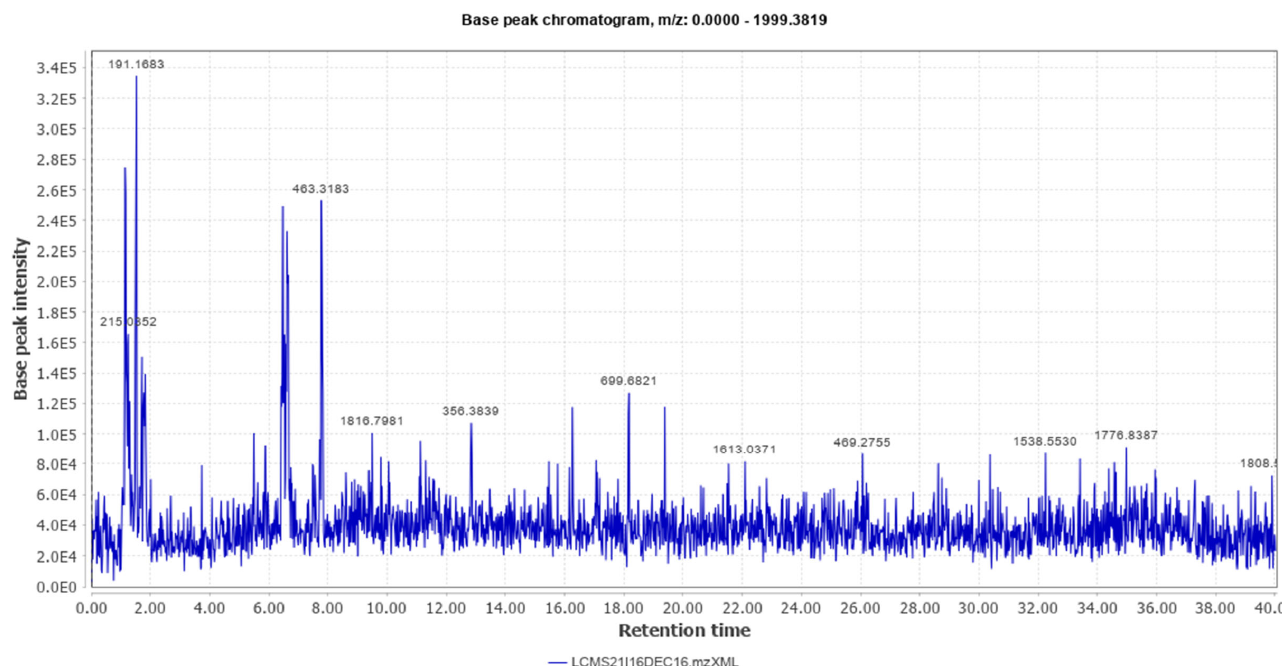
Figure 2. Total Ion Chromatogram (Negative Mode).